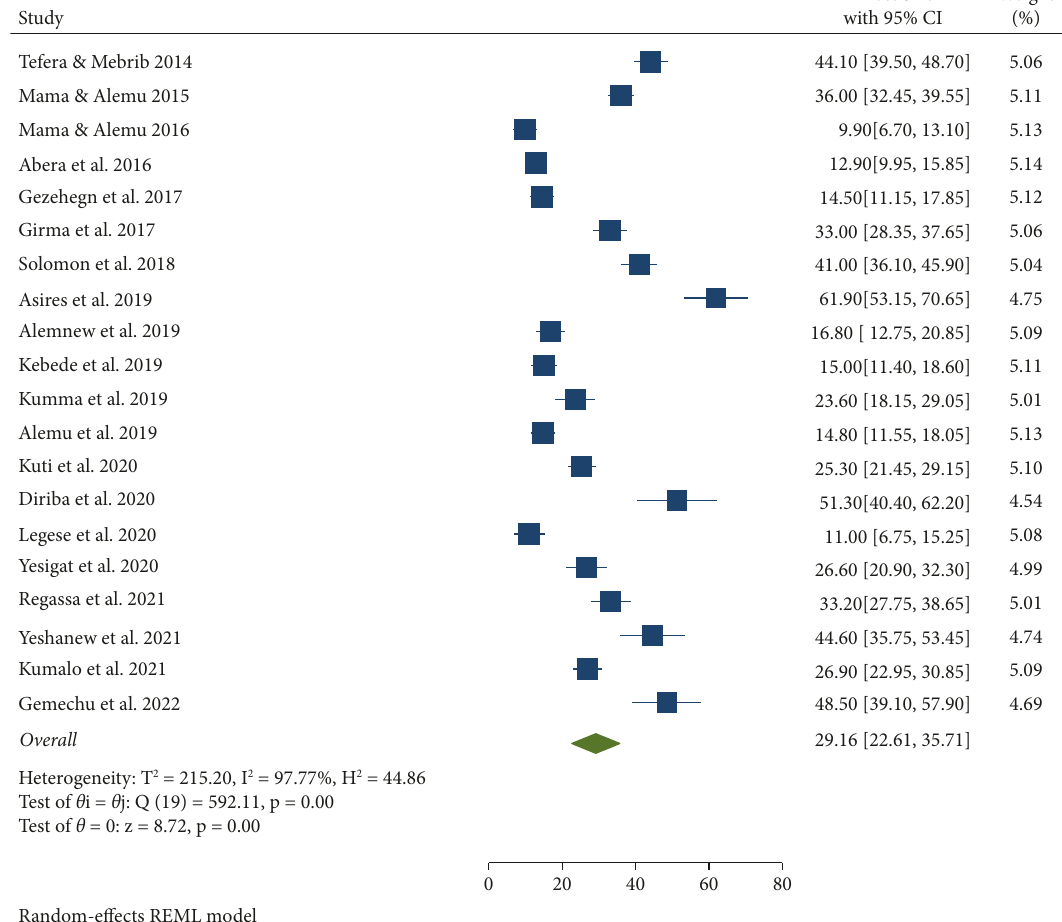
Figure 2: Forest plot of the pooled prevalence of IPs and EBIs among food handlers in Ethiopia from 2014 to